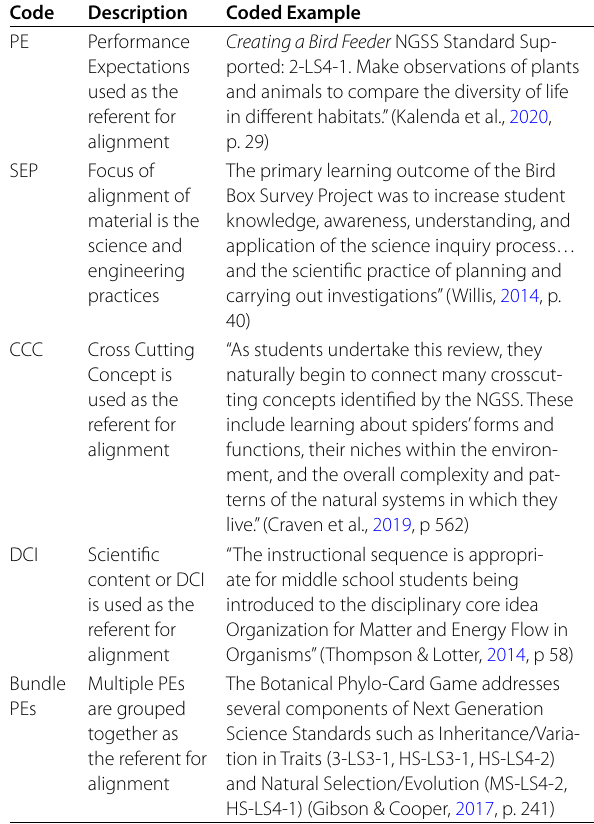
Table 3 Alignment Referent: Example Codes from the Literature Code